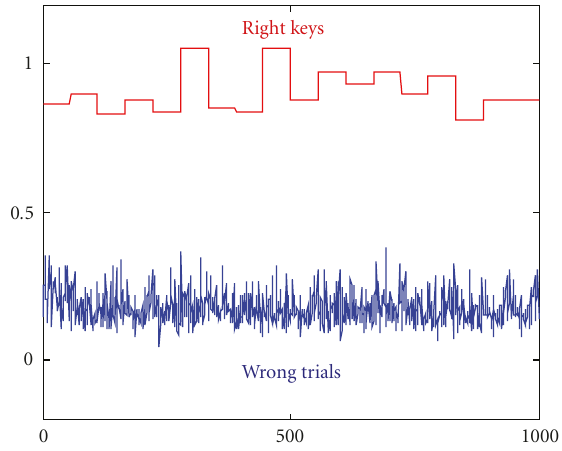
Figure 8: The normalized detector responses for a set of right keys and wrong trials; the threshold is not optimal for the considered region.